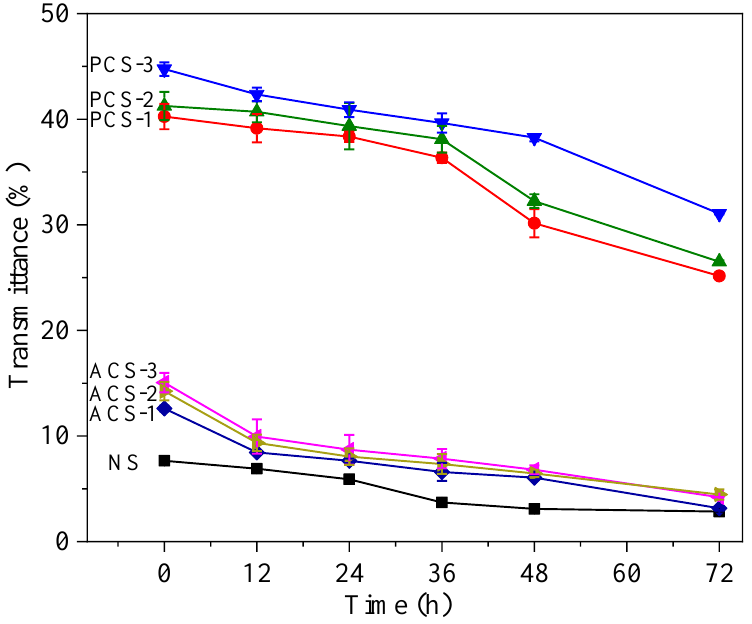
Figure 4. Light transmittance of native, phosphorylated and acetylated chestnut starch. Acetylation can also improve the clarity of chestnut starch, possibly because the intro- duction of acetyl groups hinders the formation of an ordered structure after gelatinization, and therefore suppresses retrogradation to result in a more fluid paste with higher clar- ity. Similar effects of acetylation on paste clarity have been reported for various types of starch [14,48]. Higher paste clarity is a desired property for the production of some foods, such as salad dressings and confectionery products.